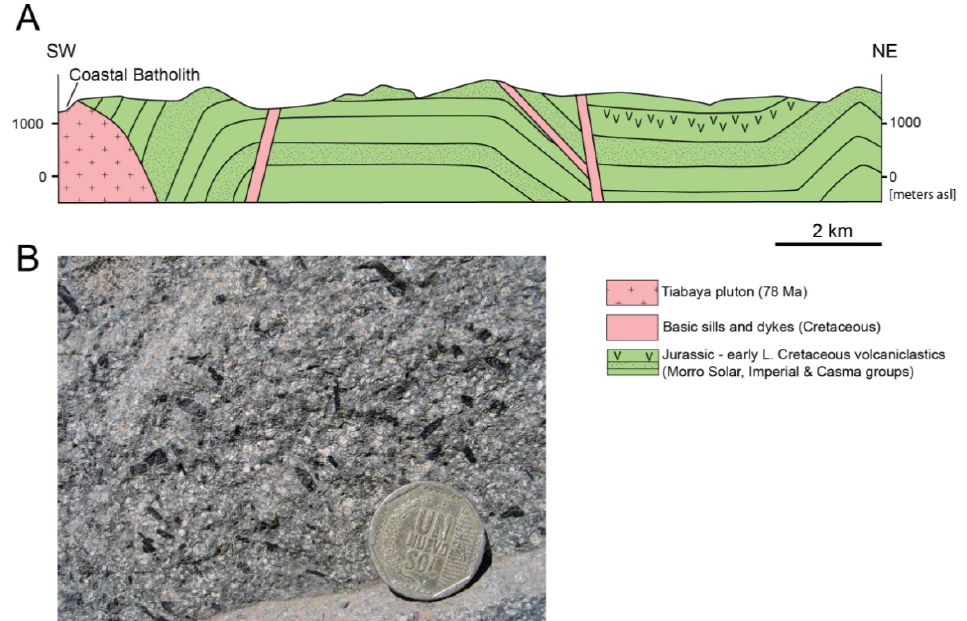
Figure 8. ( A ) Cross-section in the Coastal Belt E–NE of Cañete (see Figure 7 for location). Open folds in the volcaniclastic sequence of the Casma Volcanic Arc are intruded by the Coastal Batholith; ( B ) Photograph of a hornblende diorite from the Coastal Batholith near Lima (11°54.1' S, 76°34.5' W). Hornblende crystals and feldspars are not